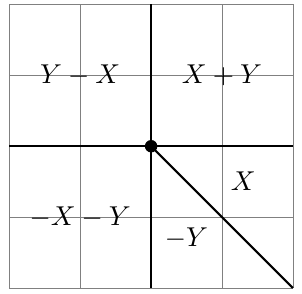
Figure 3 . The domains of linearity of X + Y − min(0 , X ) − min(0 , Y ) − min(0 , X, X + Y ) . The tropicalization procedure makes sense even if factors in R ( x ) have real exponents.